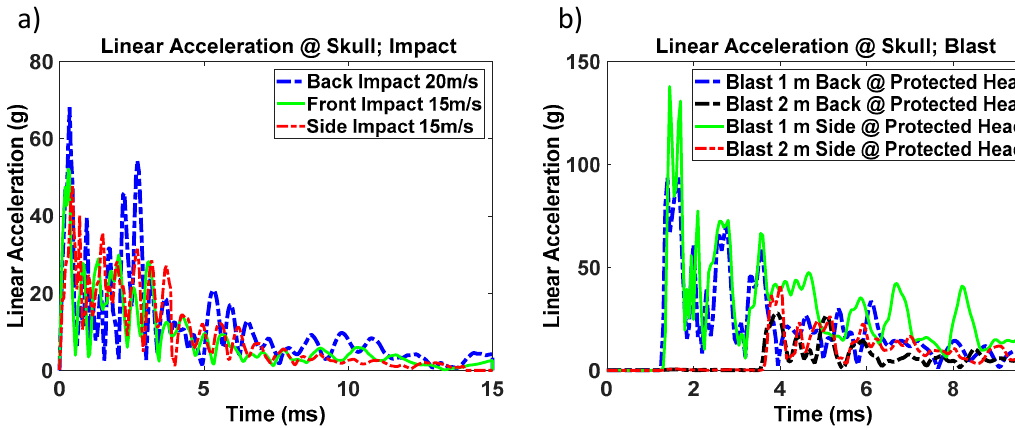
Figure 4. Resultant linear acceleration for the head skull (head) at: ( a ) impact in three directions, and ( b ) four cases of blast.